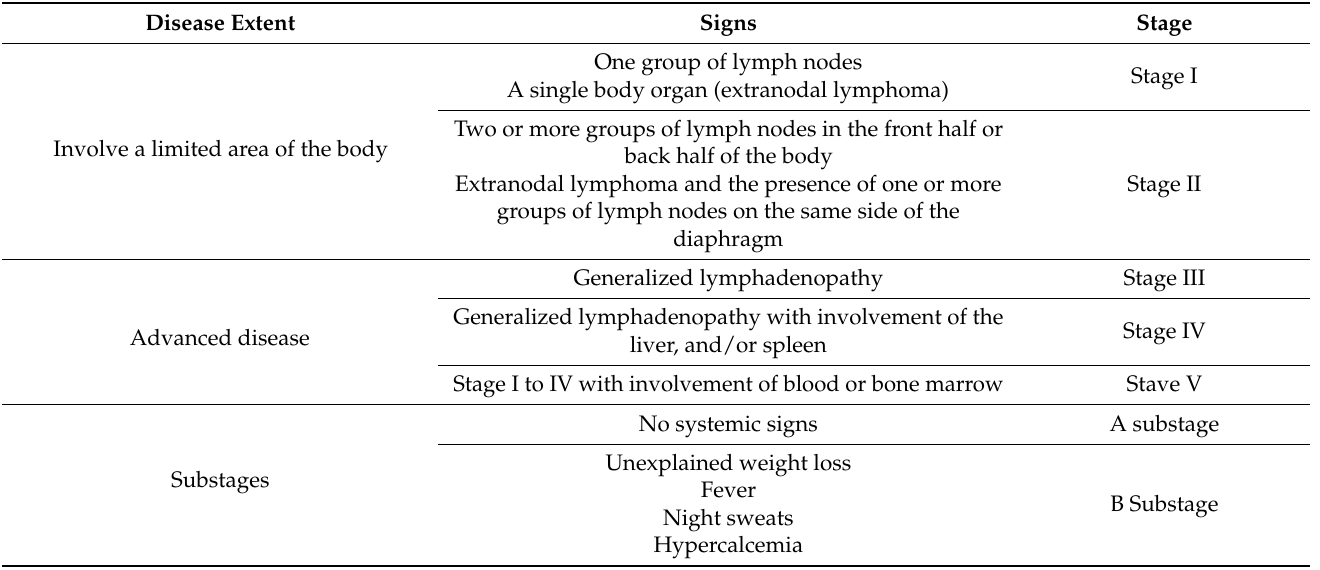
Table 1. Lymphoma grading system in dogs according to WHO classification of tumors in domestic